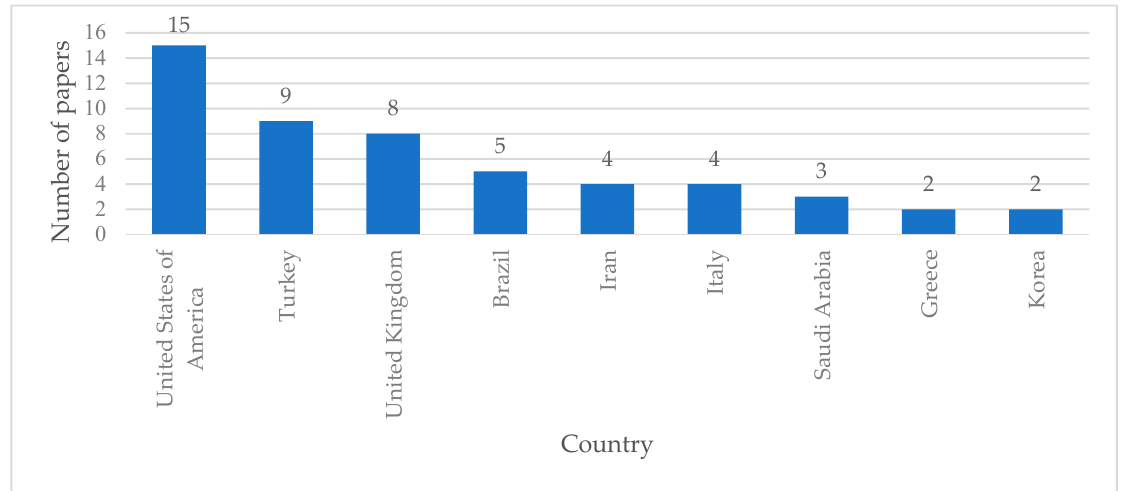
Figure 4. List of publications by country.